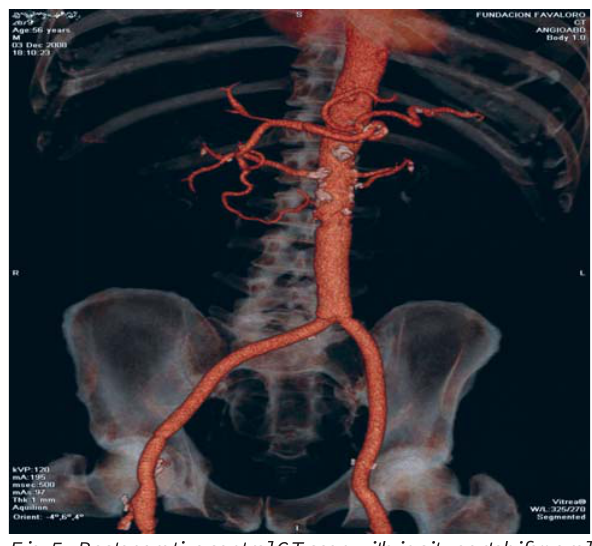
Fig. 5 - Postoperative control CT scan with in situ aortobifemoral